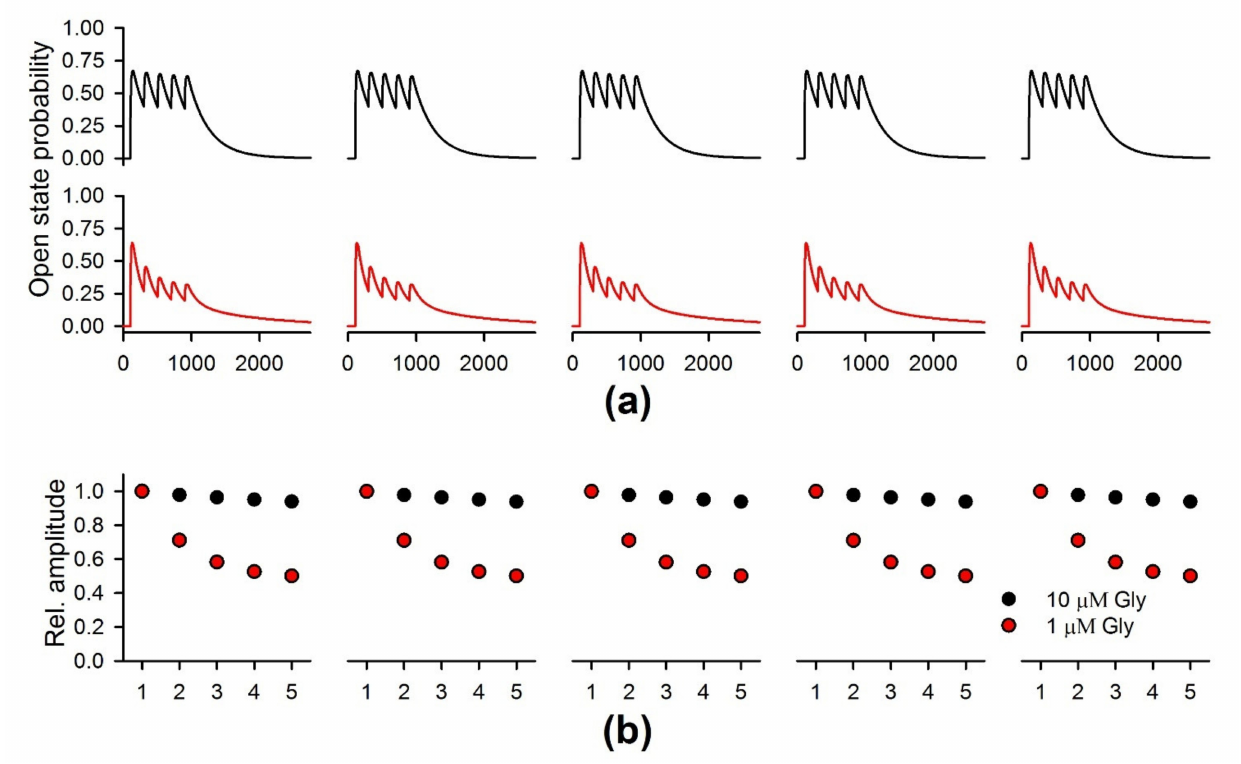
Figure 11. The simulations of the NMDAR-mediated response to TBS. ( a ) The sums of the open state probability (O1 + O1), which reflect the time course of the NMDAR-mediated synaptic currents induced by TBS. The upper traces (black) represent the 5 responses, simulated with 10 µ M of ambient glycine. The lower traces (red) were simulated with 1 µ M of ambient glycine. ( b ) The amplitudes of the individual peaks of open state probability within the responses normalized to the first peak amplitude of the first